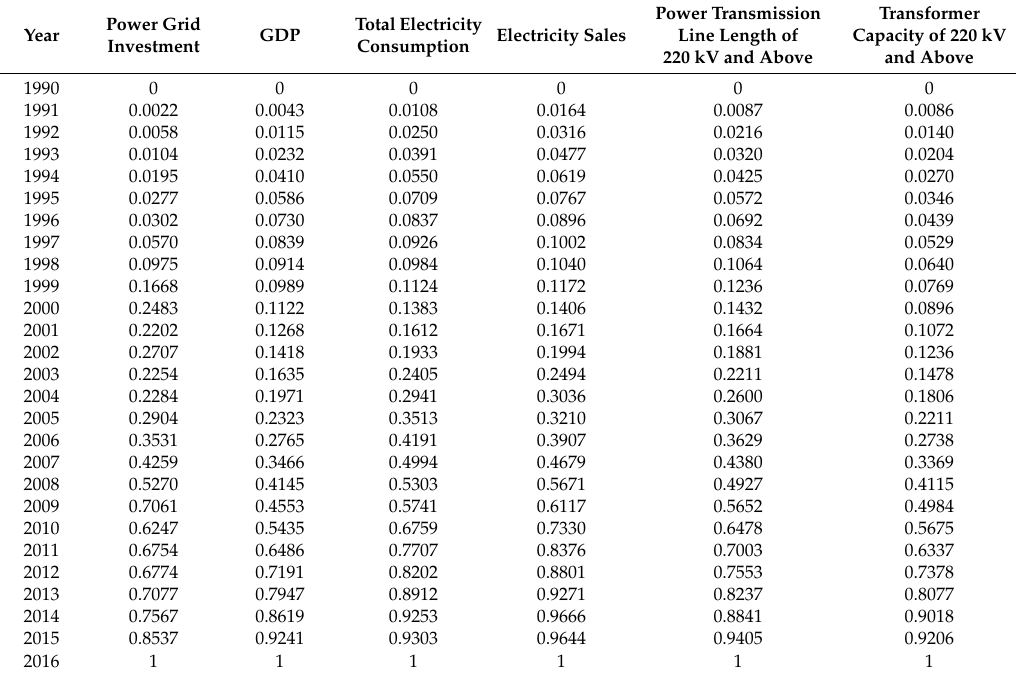
Table 2. The data after processing.